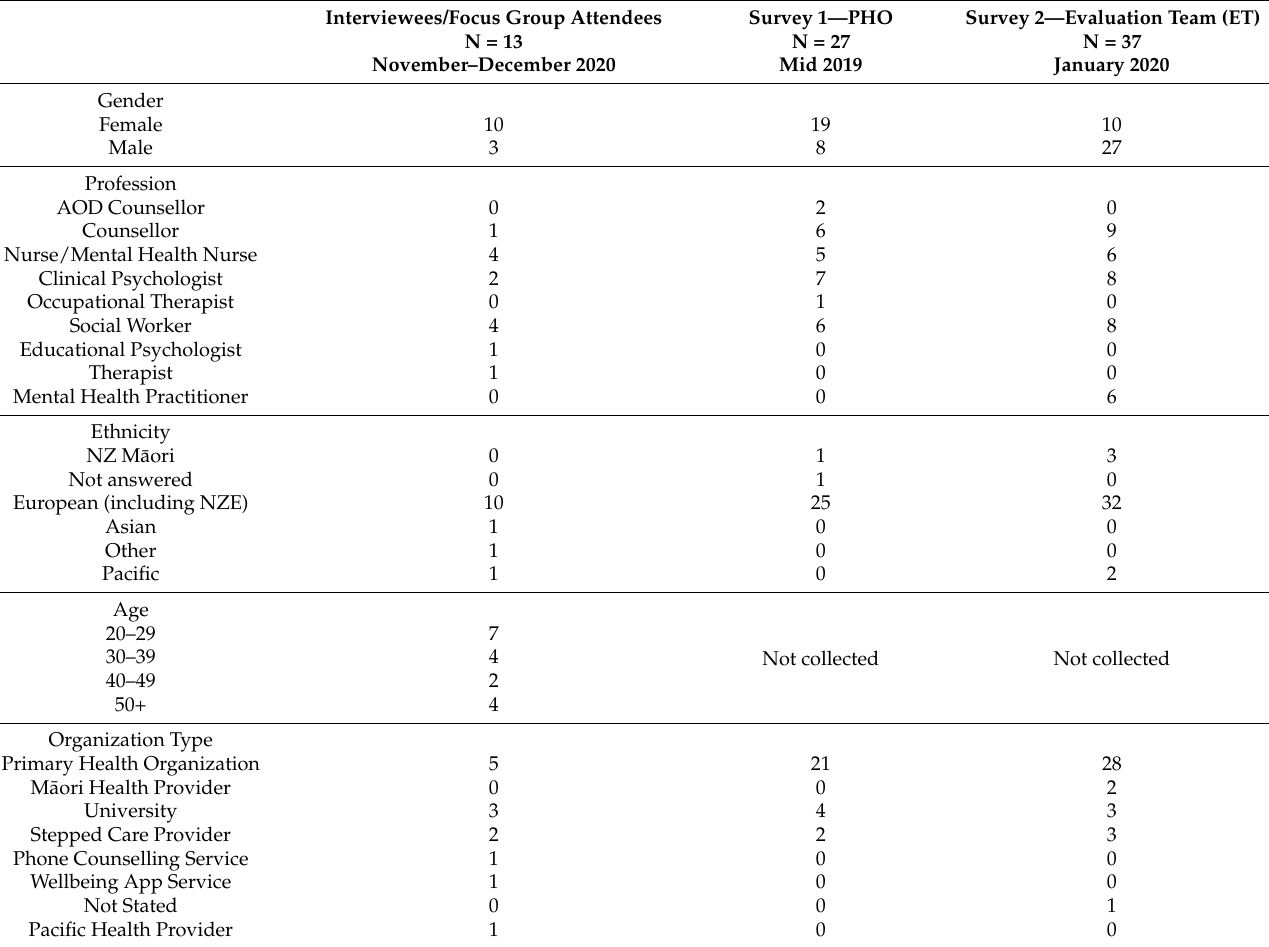
Table 1. Demographic Characteristics of